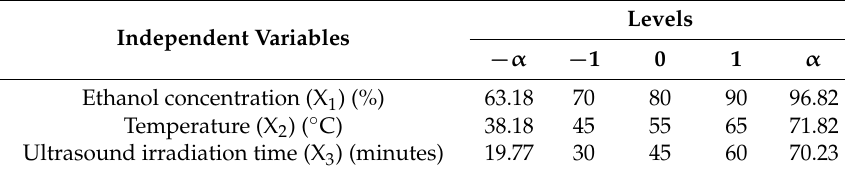
Table 1. Independent variables and their levels for central composite